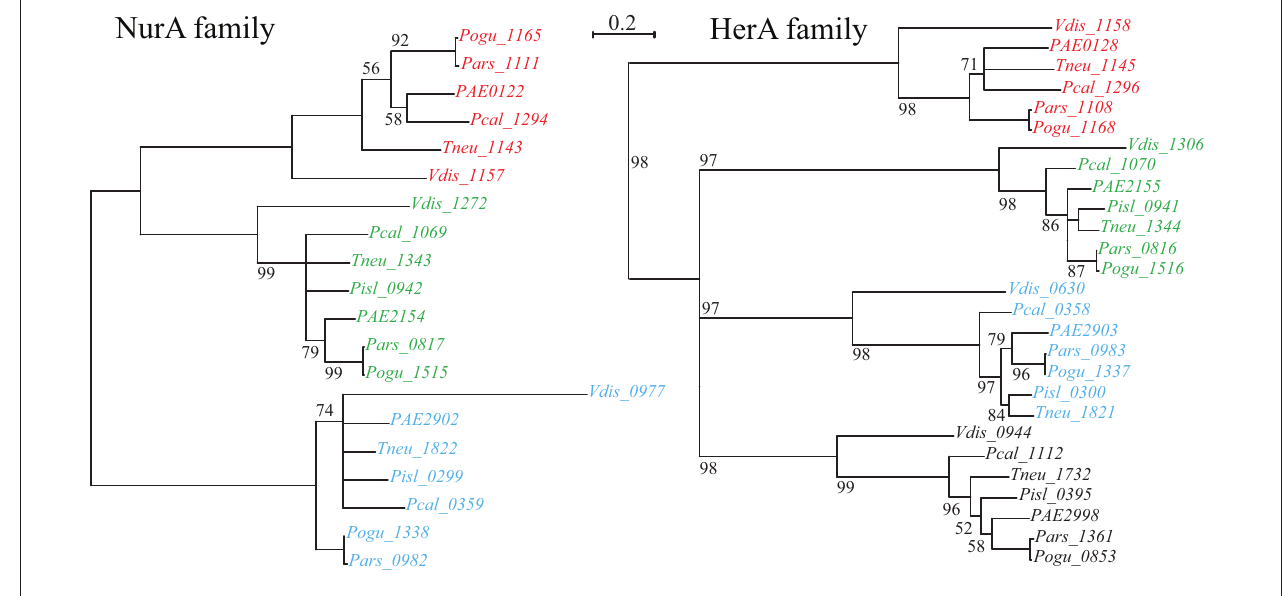
pair (Vdis_1157-Vdis_1158)is collocated in V. distributa , further supporting the tight functional association. Bootstrap percentages are included in black (100% unless otherwise noted). Gene name prefixes: Vdis—Vulcanisaeta distributa ; PAE — Pyrobaculum aerophilum ; Pars — P. arsenaticum ;